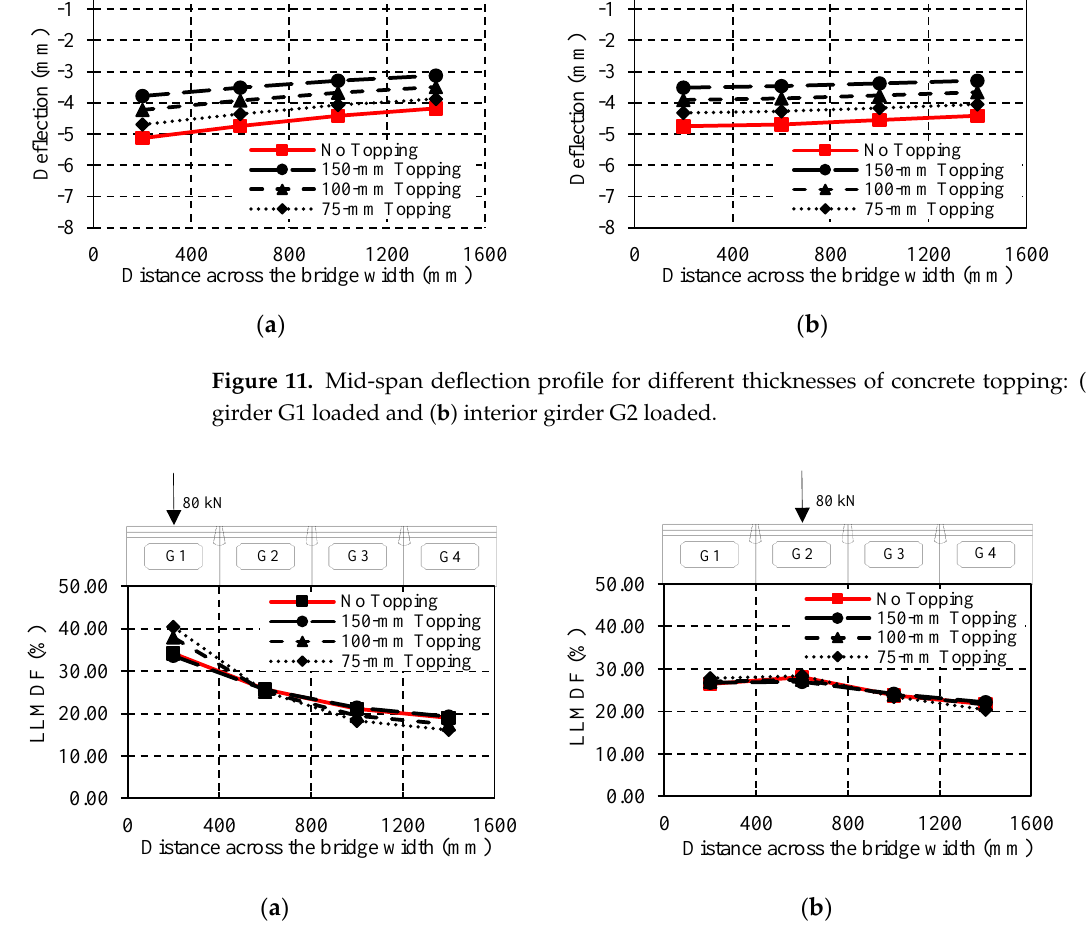
Figure 12. Mid-span LLMDFs for different thicknesses of concrete topping: ( a ) External girder G1 loaded and ( b ) interior girder G2 loaded.